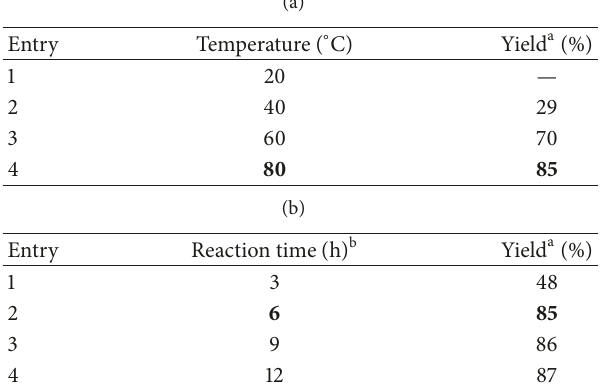
Table1:Effectoftemperature(a)andtime(b)on1-bromo-2-pheno- xyetane yield (%).